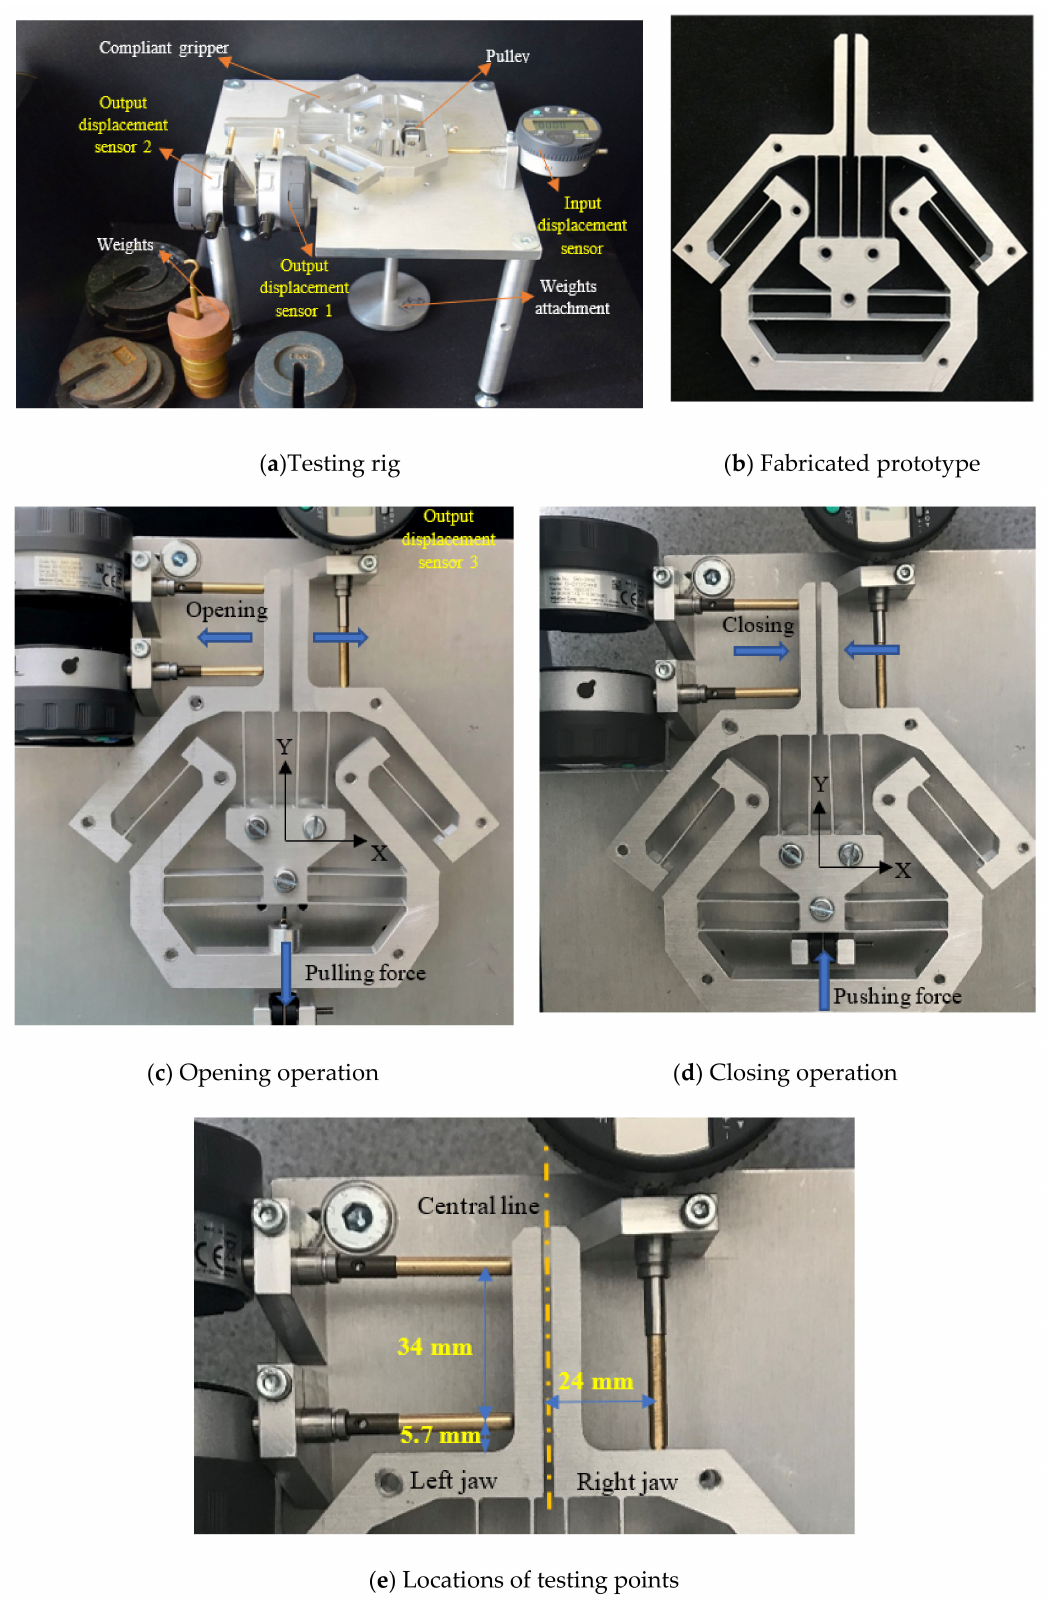
Figure 8. Fabricated prototype and experimental testing